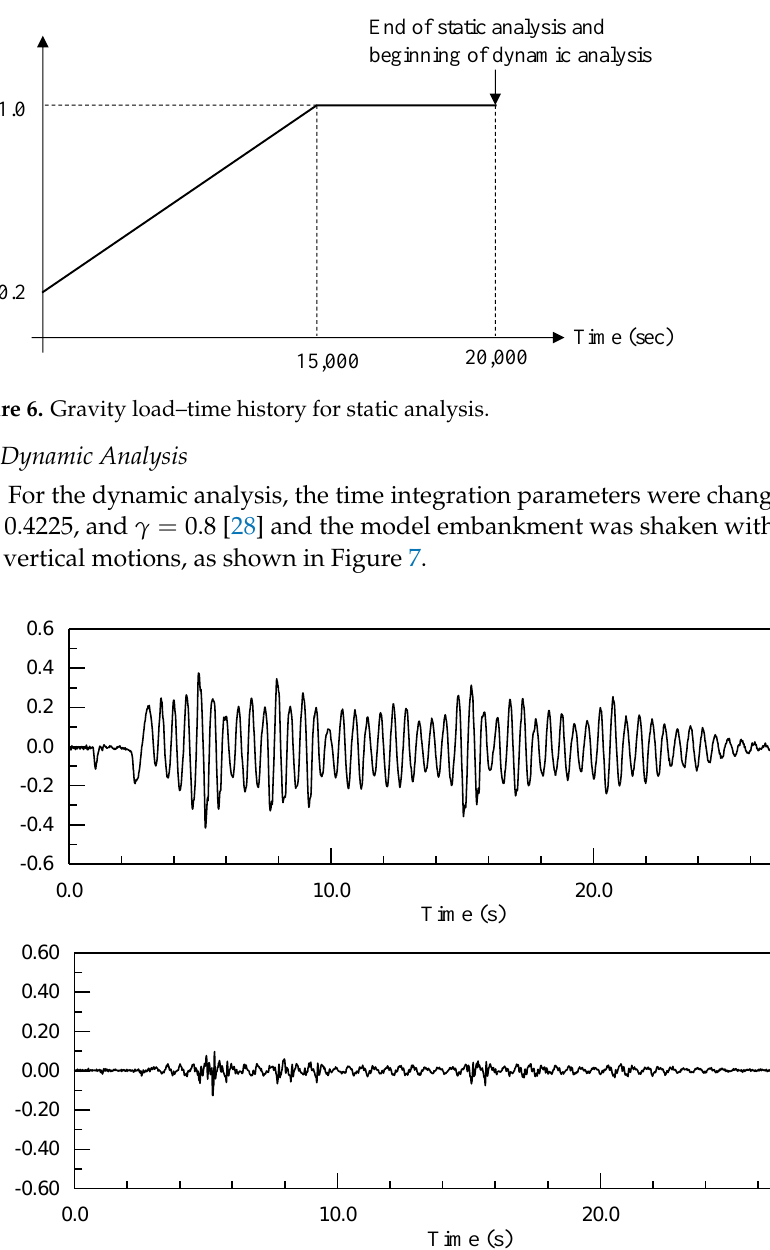
Figure 7. Input horizontal and vertical acceleration – time histories at the base of the model.